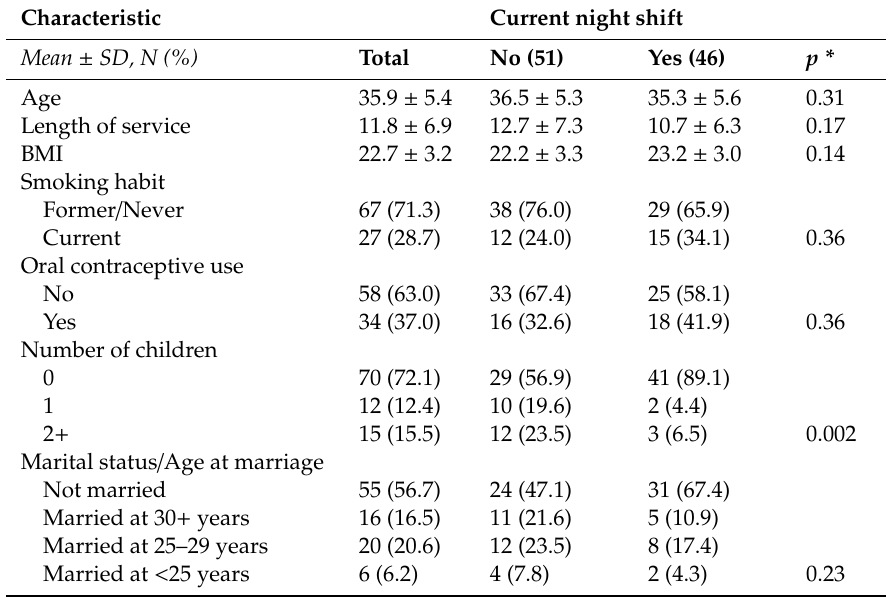
Table 1. Characteristics of the study population.